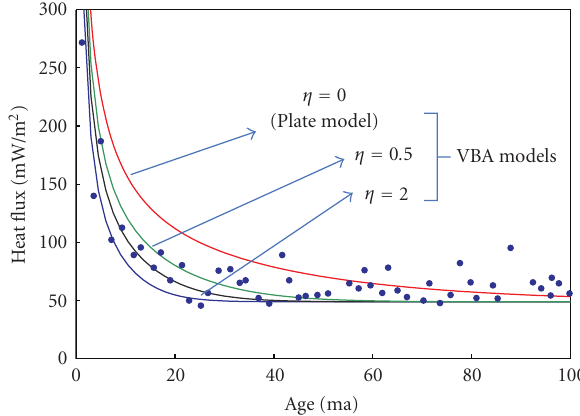
Figure 4: Comparison of VBA model values with experimental heat flow data for the oceanic lithosphere. The model values for basal accretion rates η between 0.5 and 2 are indicated by the set of blue, black, and green curves. The red colored curve refers to the case η = 0. It represents the lower end-member case of the family of VBA models and is identical to that derived from the Plate model